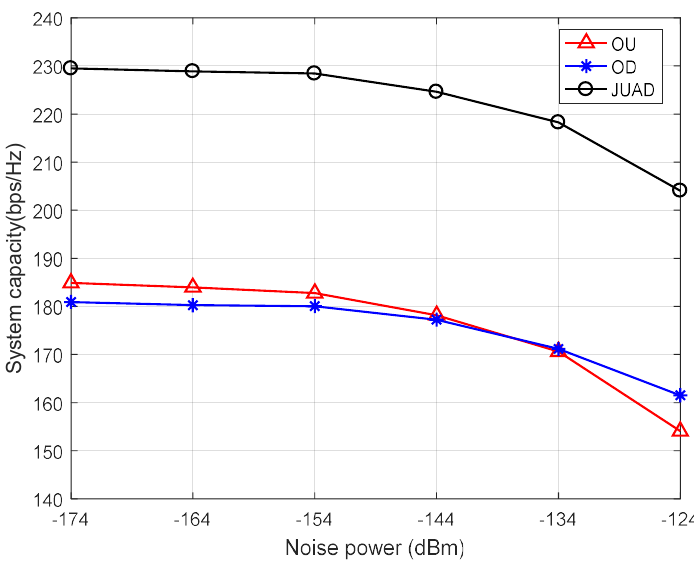
Figure 4. The system capacity with varying noise power, comparison of the JUAD/ OU/OD resource allocation schemes.